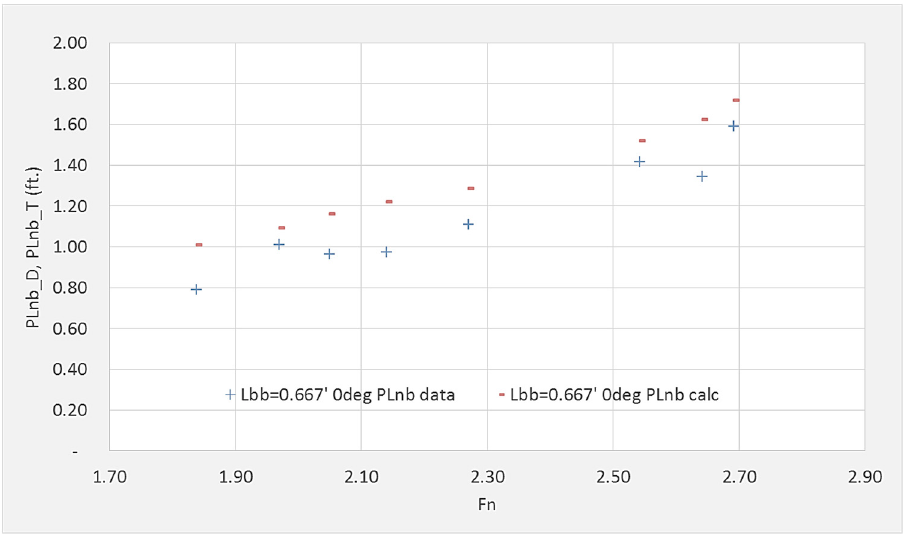
Figure 14. PL nb_data and PL nb_calc for bulbs with 0 ◦ pitch angle.